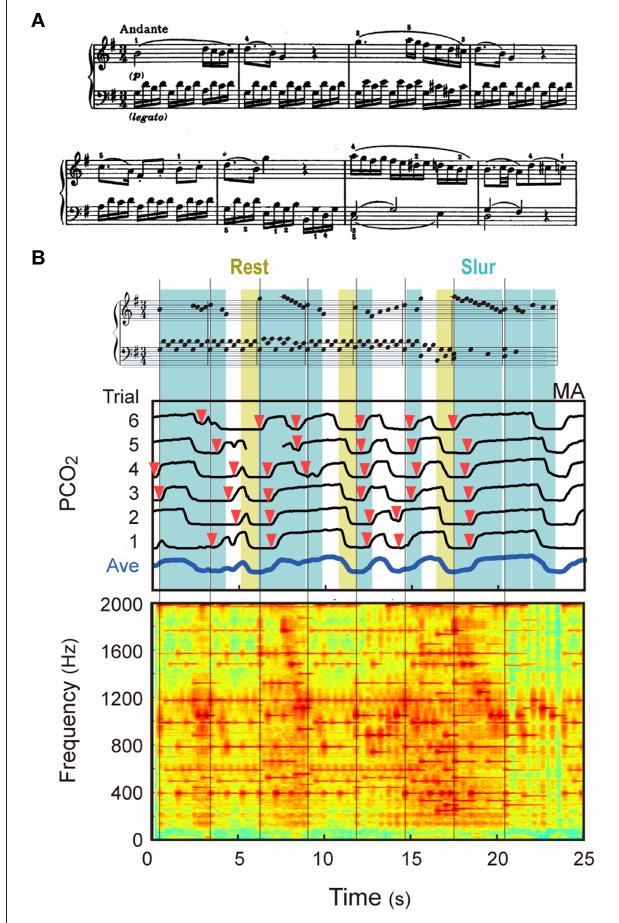
FIGURE 3 | Example of breathing pattern in piano playing. (A) The score of the first 8 bars of Excerpt F used in the experiment is shown. (B) The middle panel shows the PCO 2 temporal patterns of six trials of one Participant, together with their averaged pattern [ avePCO 2 ( t )]. The temporal axes for these patterns were matched to each other using the dynamic time warping method. The bottom panel shows a part of the sound spectrogram used for the time warping. The top panel shows the rearranged score so that the timing of each note is arranged in accordance with the physical time. Each vertical line indicates the timing of the first note of each bar, and red arrows represent the timings of the expiration onsets estimated from the PCO 2 patterns. The respiratory pattern of this participant apparently corresponds to the musical